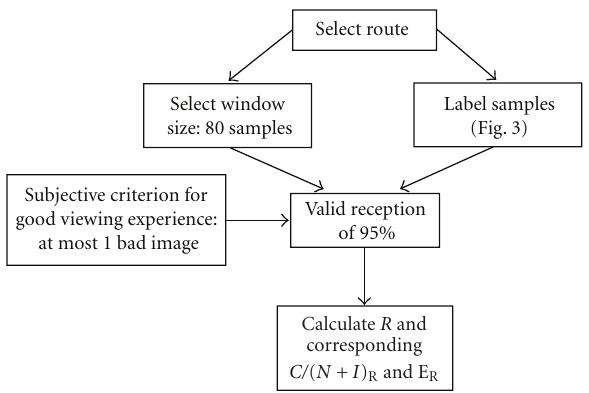
Figure 2: Flow graph illustrating the procedure to calculate R, CINR R , and E R